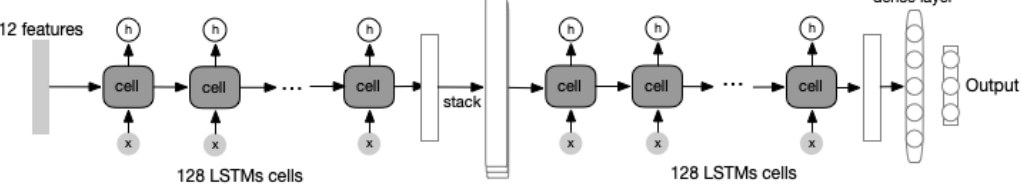
Figure 4. The basic architecture is relatively straightforward as only 12 features are provided. The information is first encoded by the “encoder” module and an intermediate latent vector, which contains the key value as well as the relationship between the elements, is produced. Then, this vector is stacked in order to match the prediction frame numbers and fed to the “decoder” module and generated a new representation of the original input. The new representation is used to train the final dense layer to predict the acceleration. Given one video clip with a frame-length of 10, the input is the vector consists of 12 features from these 10 frames. The output is the acceleration for the next five frames starting from the end of the video clip. The “encoder” module contains 128 LSTM-cells and the “decoder” module contains 128 LSTM-cells. The optimizer of this network is RMSprop with learning rate 0.0001 and the dropout is used for each LSTM-cell with probability